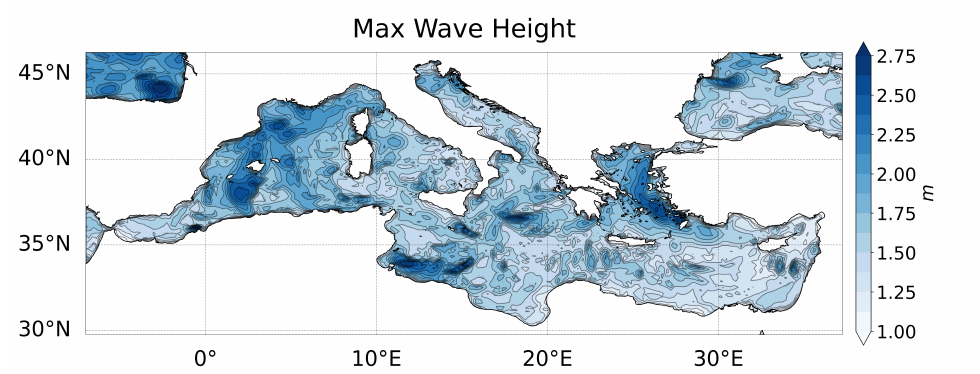
Figure 14. Calculated maximum wave heights using the 10 m wind speeds from the WRF/ORCHIDEE model outputs and Equation